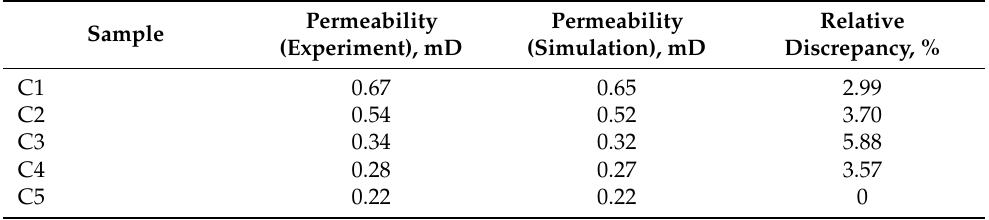
Table 3. Comparison between simulated results of core permeability and experimental results.